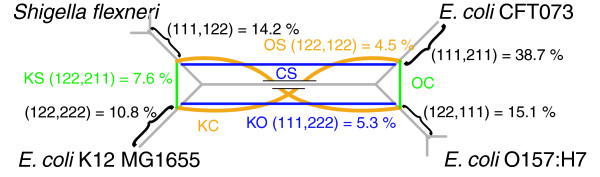
Percentage of SNDs supporting each of three topologies in a phylogenetic network for six E. coli genomes (four OTUs). Black lines describe the 'species' topology. Green, blue, and orange lines indicate the alternative pairings of sister taxa that result from KS, KO, and KC recombinations, respectively. Also shown is the percentage of SNDs supporting each bipartition in Table 1.